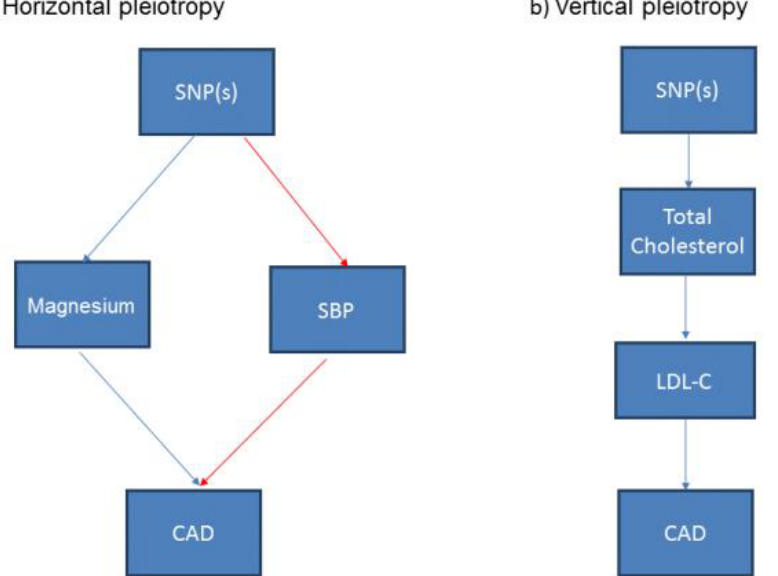
Figure 4. Simplified illustration of ( a ) horizontal and ( b ) vertical pleiotropy in Mendelian Randomiza- tion in nutritional research. This illustrates that ( a ) horizontal pleiotropy occurs when the SNPs have effects on multiple exposures that are independent of each other; ( b ) vertical pleiotropy occurs where the effects of one exposure can have a downstream impact on another related exposure. SNP: Single nucleotide polymorphism; SBP: Systolic blood pressure; LDL-C: Low density lipoprotein cholesterol; CAD: Coronary Artery